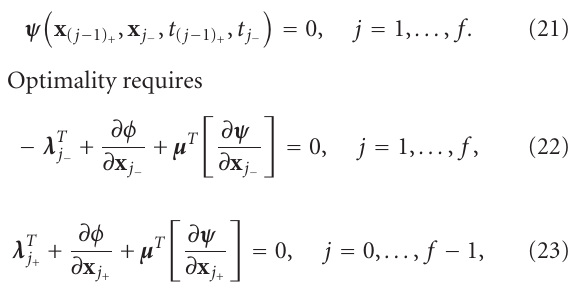
is the Earth radius. The spacecraft is instead on the surface of a cone (centered at the Sun with axis on the Earth-Sun connecting line) with semi-angle γ = sin − 1 ( r sin δ/R ), where the angle δ between the Earth centered vectors pointing to the Sun and spacecraft is evaluated as δ = cos − 1 [( r s ) The spacecraft is in the Earth shadow when ( r s ) γ < γ shadow . Results show that, in the present case ( m = 960kg, S = 5 . 7m 2 ), solar radiation pressure has a negligible influence on performance, causing variations of the final mass of a few